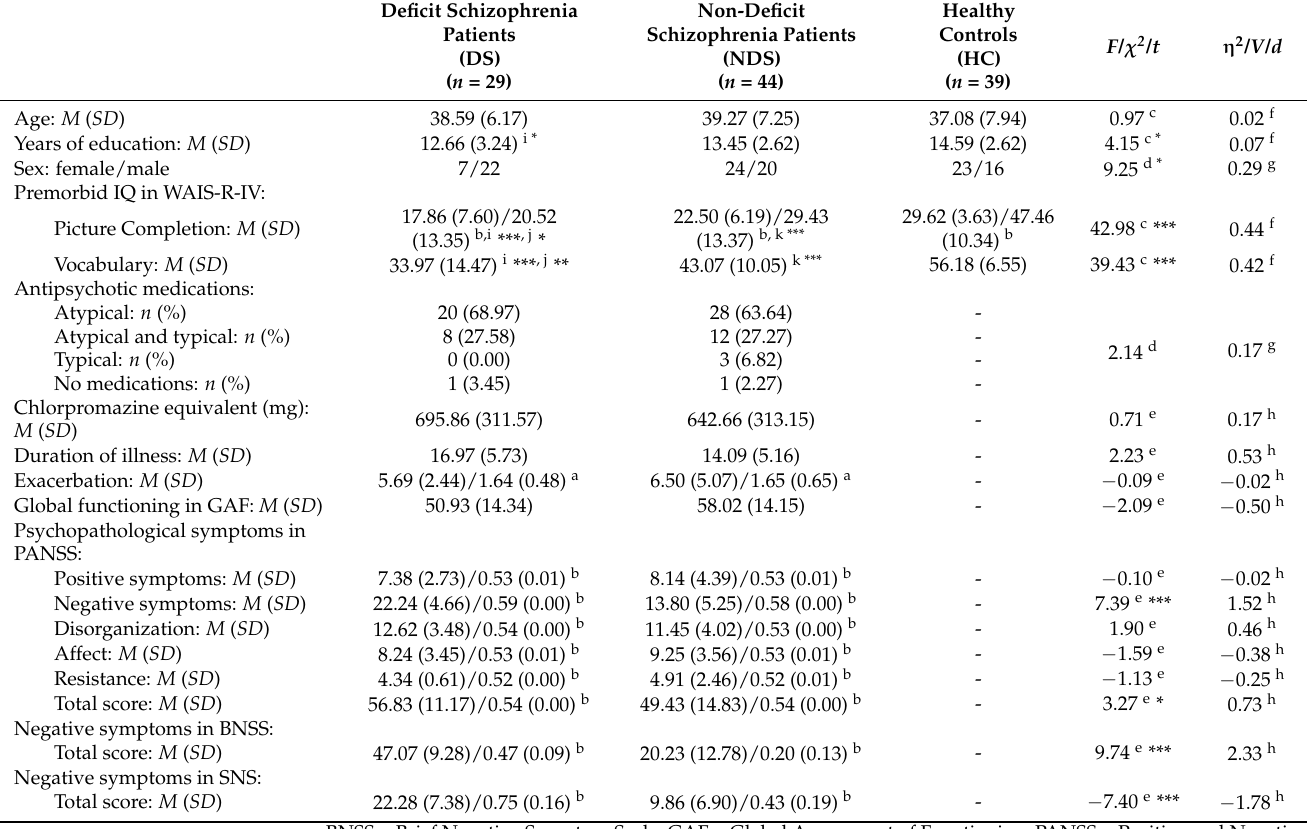
Table 1. Demographic and clinical characteristics of all participants. Deficit Schizophrenia